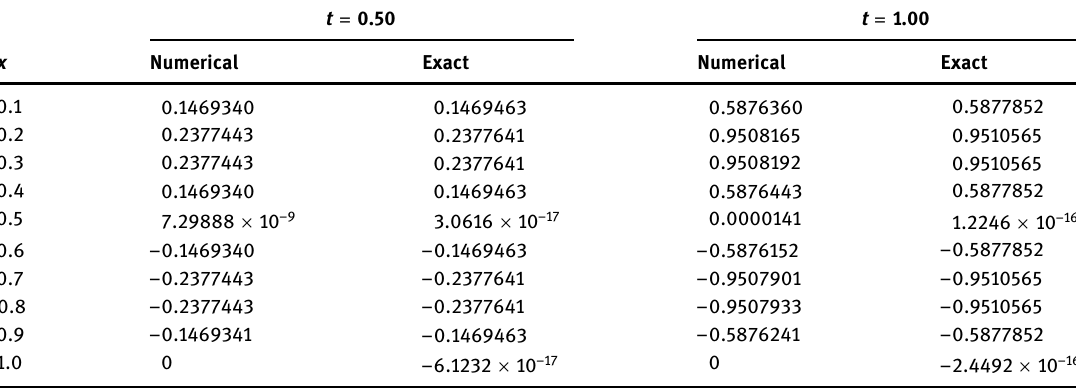
Table 7: U i j , and u i j , with α 0.75